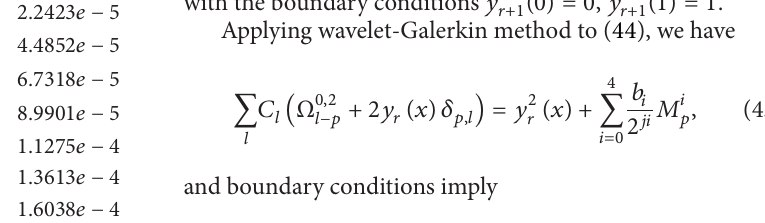
and solution by the exact NEW